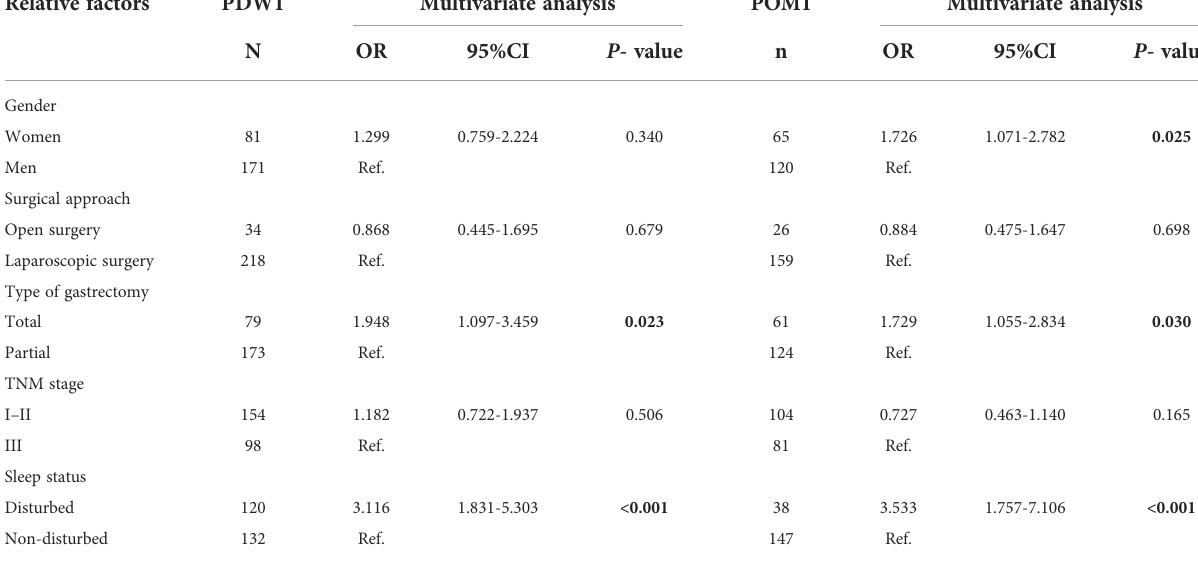
TABLE 4 Multivariate logistic regression analysis of risk factors for PGISs.